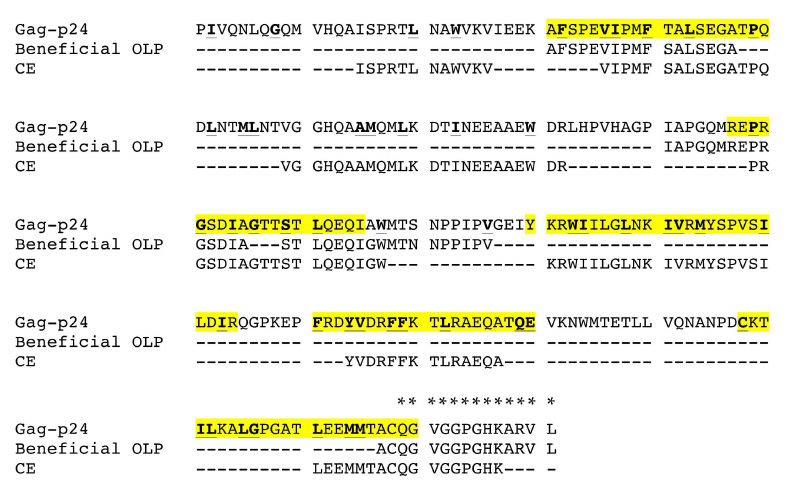
Figure 8. Clusters of sites prone to destabilizing mutations overlap with peptides shown to induce robust immune response and be associated with viral control. Positions prone to destabilizing mutations are underlined and bolded in HIV-1 Gag-p24 subtype B consensus sequence. Yellow regions depict four continuous stretches of sites found in three or more overlapping 15 amino acid windows with each window containing five or more destabilizing sites. CE peptides [3,14,41] and “Beneficial” peptides from [42] were previously shown to induce robust immune responses [43,44] and associated with viral control [42], respectively. * denote residues not included in all the template structures examined and, hence, excluded from the